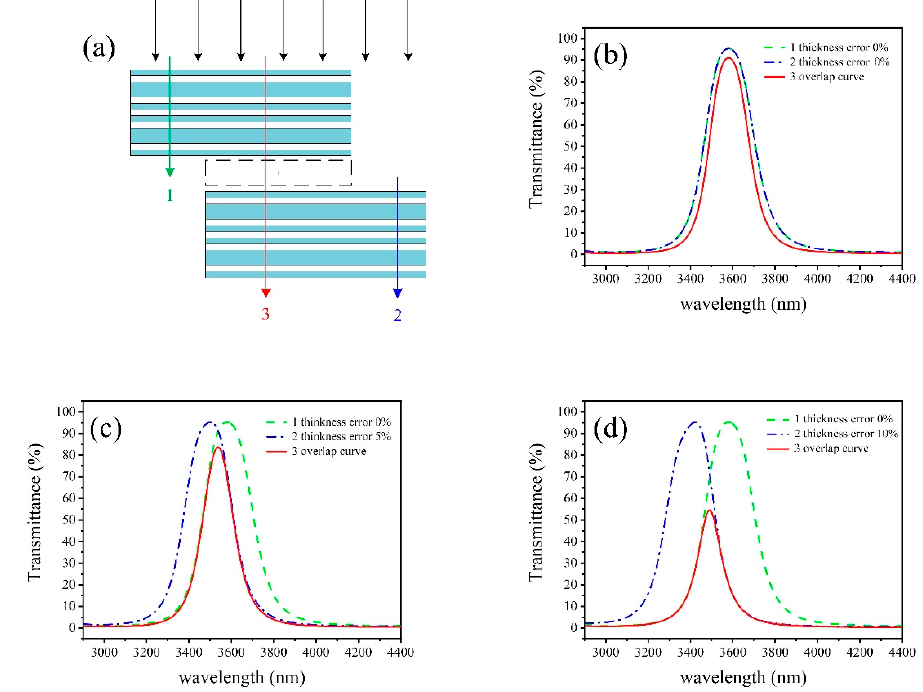
Figure 15. ( a ) The schematic diagram of two designed filters with the same film structure HL2HLHLHL2HLH, the three calculated curves when one filter is HL 2H LH L HL 2H LH, the other filters are HL 2HLHLHL2HLH ( b ), HL1.9HLHLHL1.9HLH ( c ), HL1.8HLHLHL1.8HLH ( d ), respectively.